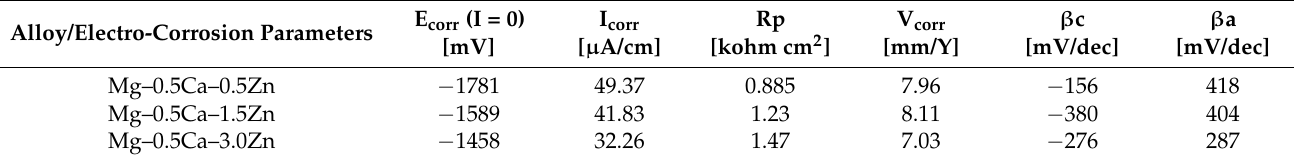
Table 7. Electro-corrosion parameters (average values from three